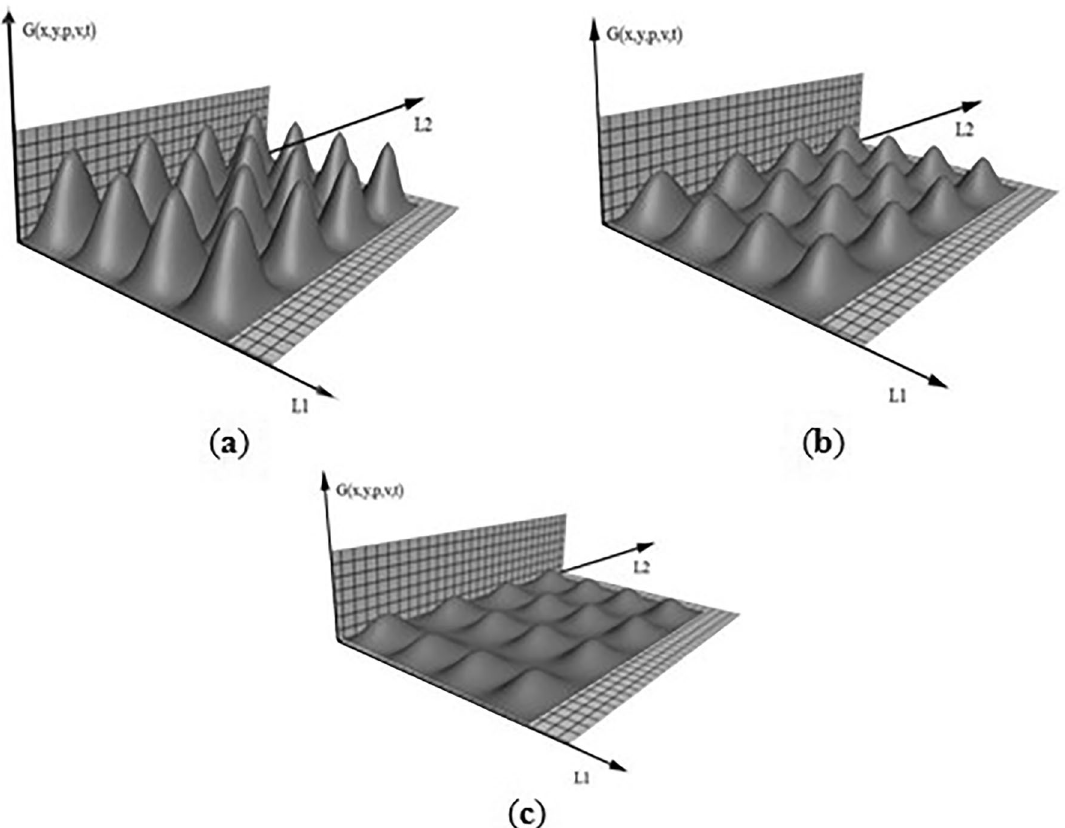
Figure 4. Dynamic change of the temperature field depending on time. ( a ) before change; ( b ) cycle change; ( c ) after change (RAD Studio 11.1 programming environment Delphi https:// www. embar cadero. com/ produ cts/ rad-